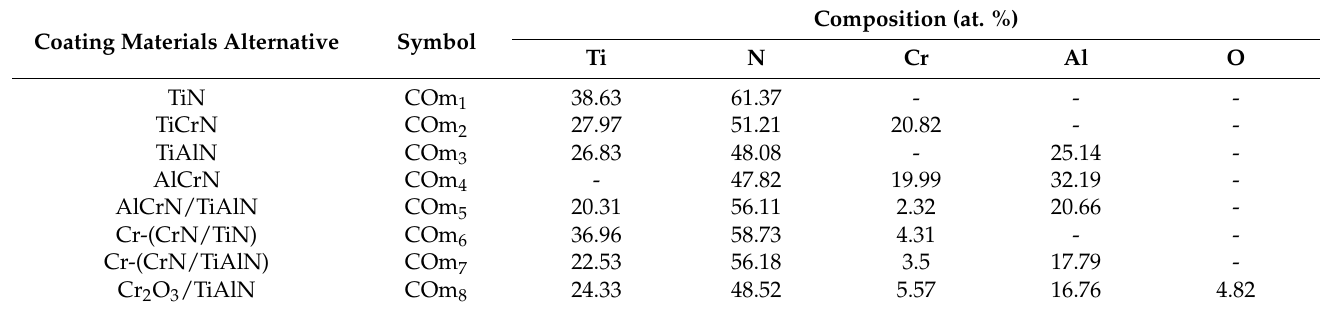
Table 1. Coating material alternatives and their chemical composition.